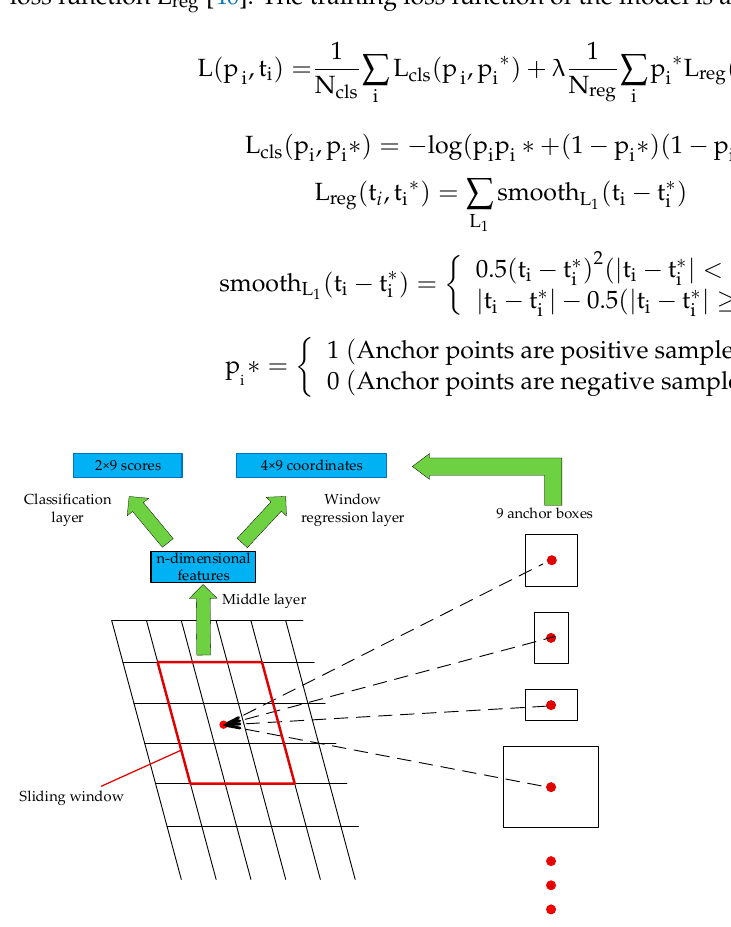
Figure 4. RPN structure.